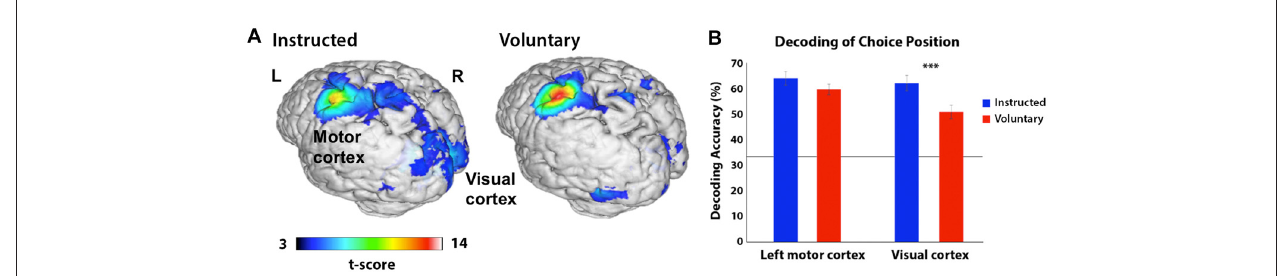
FIGURE 4 | (A) Areas in which a searchlight analysis revealed significant decoding of the door position participants were preparing to choose (left, middle or right) in corridor task phase 2 (when the doors became visible). The t -score represents the group-level significance of decoding. Decoding accuracy was highest across conditions in the left motor cortex, but a second cluster in the visual cortex also contained discriminatory information ( p < 0.05 FWE-corrected). Results are presented on a 3D-rendered standard brain template with Mango, thresholded at p < 0.001 for ease of viewing. (B) Decoding accuracy in the peak coordinates from (A) based on the position participants were preparing to select, separated by region and condition (Instructed in blue; Voluntary in red). The line represents chance accuracy (33%). In the left motor cortex, there is a trend towards higher decoding in the Instructed condition and in the visual cortex this difference is highly statistically significant ( ∗∗∗ p < 0.001). The horizontal line depicts chance accuracy (33%).